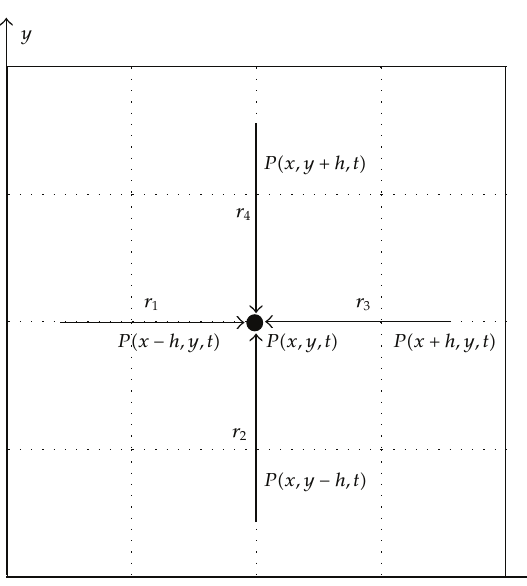
Figure 1: Probabilities of walking